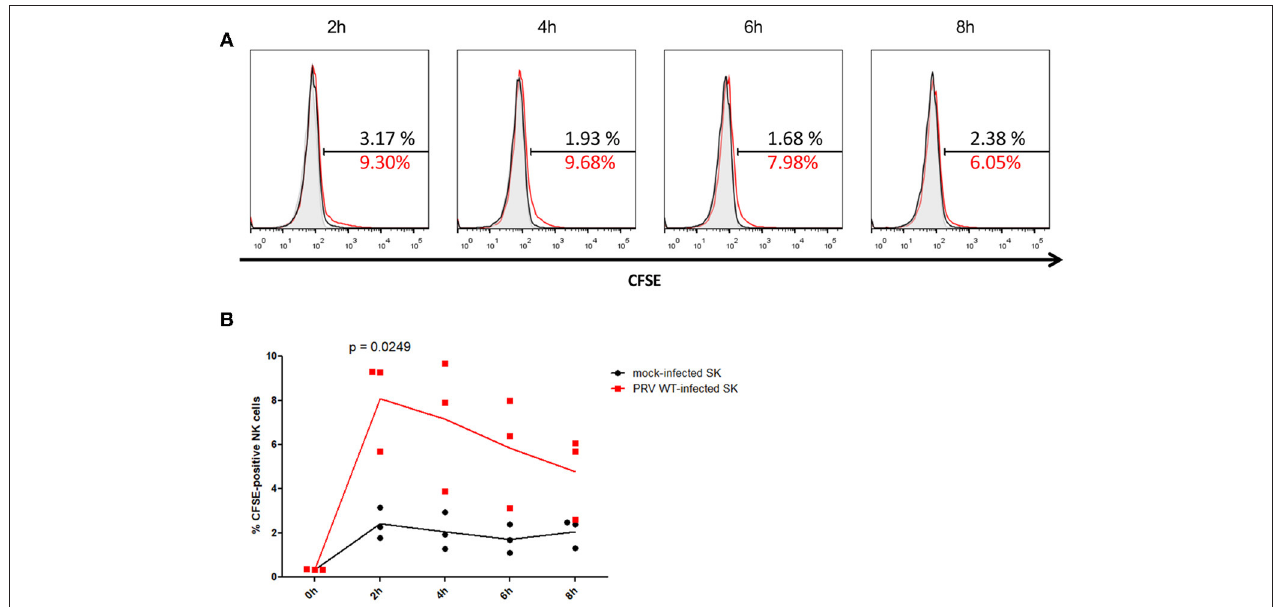
FIGURE 1 | Porcine NK cells internalize fragments of killed PRV-infected target cells. (A) Histograms show the CFSE signal of IL-2-primed NK cells that were incubated for the indicated times with PRV WT-infected SK cells (NK:target ratio 25:1) that had been labeled with CFSE (red open histogram), CFSE-labeled mock-infected SK cells (black open histogram) or not incubated with target cells (gray shaded histogram) of one representative pig (out of three). The amount of CFSE-positive cells (%) is indicated in the histograms. (B) Graph shows the amount of CFSE-positive IL-2-primed NK cells that were co-incubated for the indicated times with CFSE-labeled mock-infected SK cells or PRV wild type-infected SK cells (effector target ratio of 25:1). Dot plot shows the results of three individual blood donors and the mean values are connected with a line. P -value threshold for statistically significant differences was 0.05, p -values are indicated in the